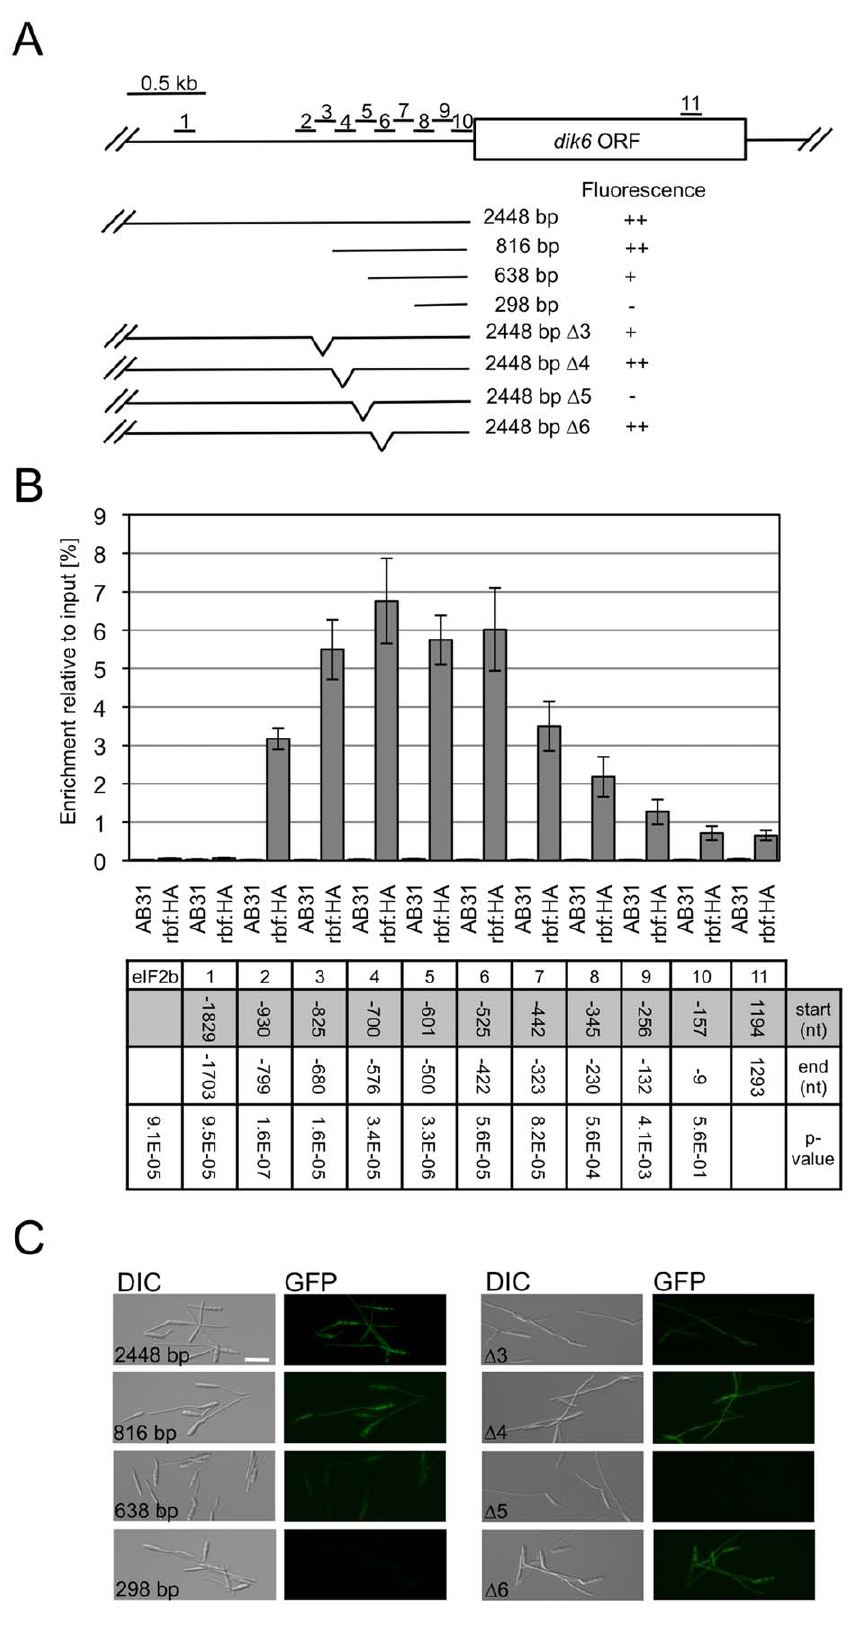
Figure 6. Rbf1 binds to the promoter of the Rbf1-dependently expressed dik6 gene. (A) Overview of the dik6 promoter region investigated by qChIP in strain AB31 rbf1:3xHA . Shown are the positions of the amplicons used for qChIP (numbered from 1 to 10) and the promoter truncations and internal deletions assayed in the GFP-reporter assay. (B) qChIP analysis of Rbf1-binding to the dik6 -promoter in strains AB31 and AB31 rbf1:3xHA